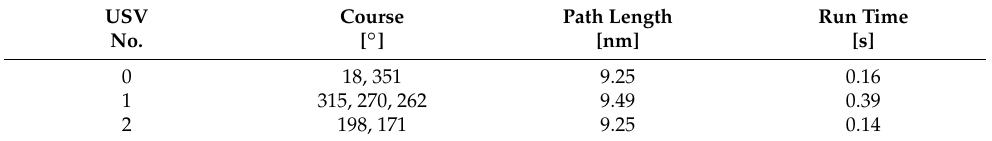
Table 11. Output data of test case